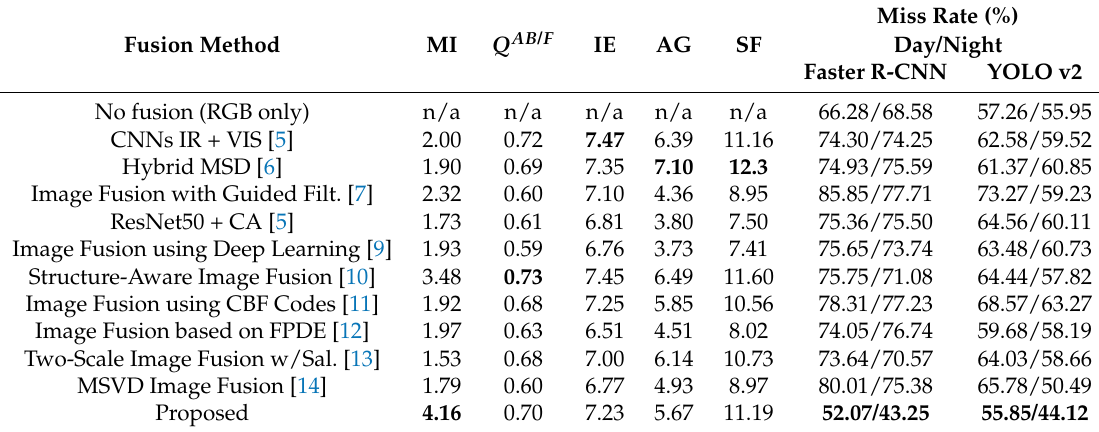
Table 1. Qualitative comparison of the proposed method with ten image fusion methods using samples from the KAIST Pedestrian Benchmark. The metrics are averaged from all day and night images in the test